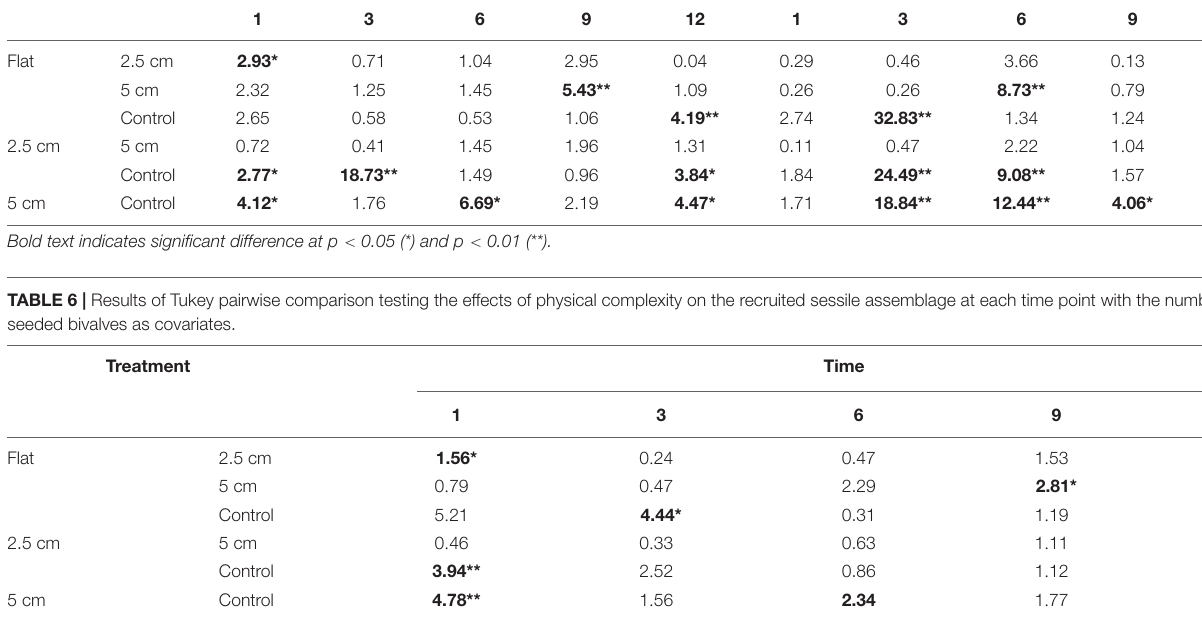
TABLE 5 | Results of Tukey pairwise comparisons testing the effects of physical complexity (pooled over seeded and unseeded treatments) on the recruited sessile assemblage at each site at each time point. Penang Port